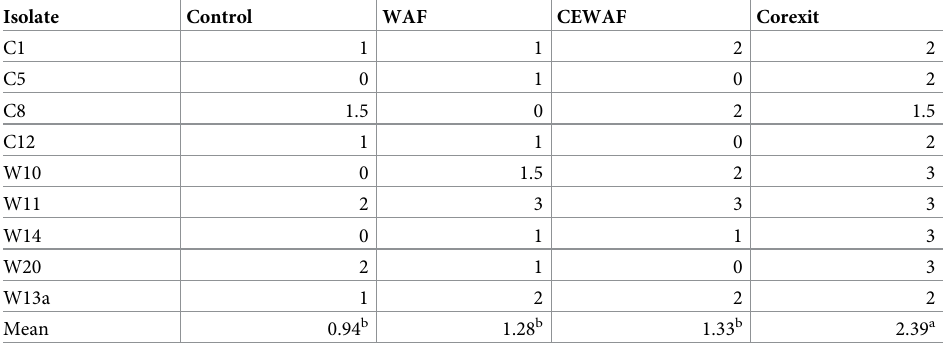
Table 2. Visible aggregates (mucus) observed after 4 d of incubation in control, WAF, CEWAF, and Corexit. The values represent the average of duplicate samples. (0-none; 1-present; 2-more; 3-